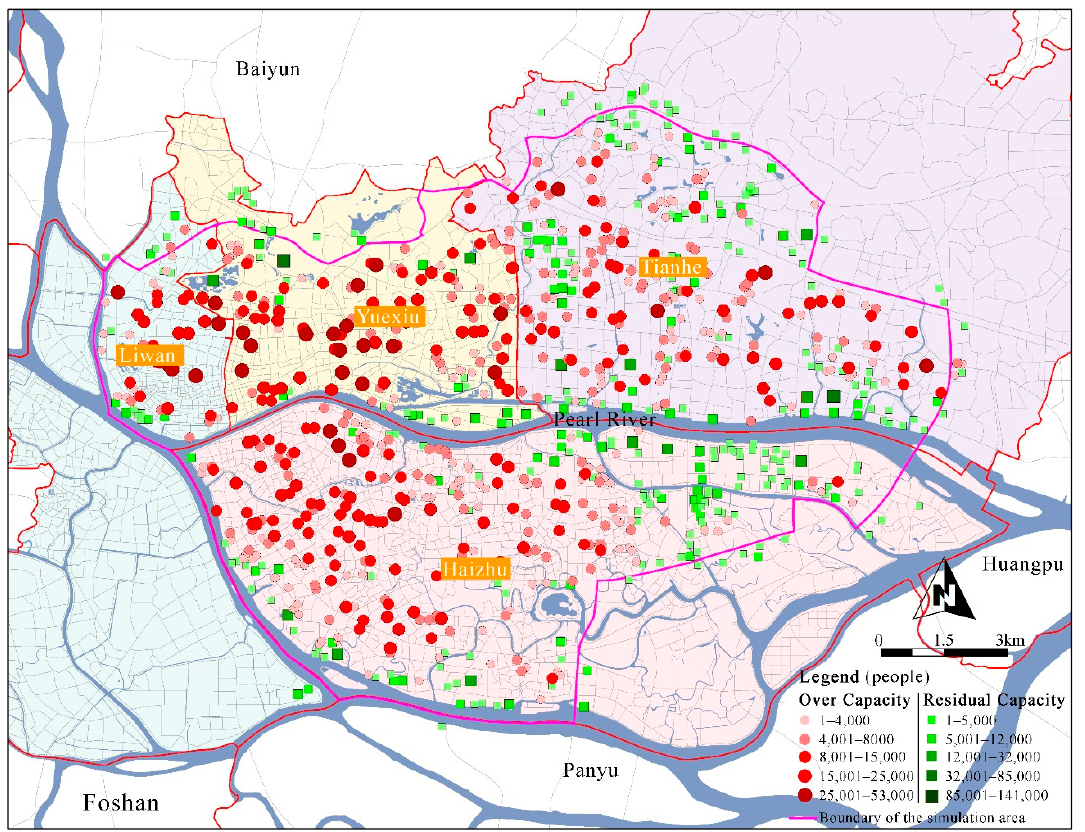
Figure 9. The final state of shelters after the evacuation simulation.